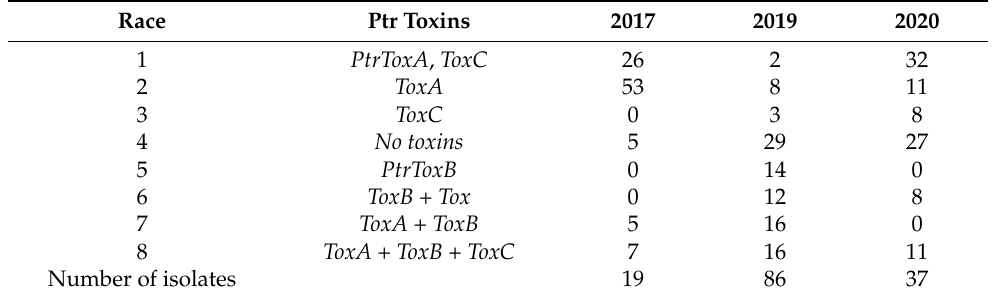
Table 4. Frequency of Pyrenophora tritici-repentis races in Chelyabinsk region on spring soft wheat (%). Race Ptr